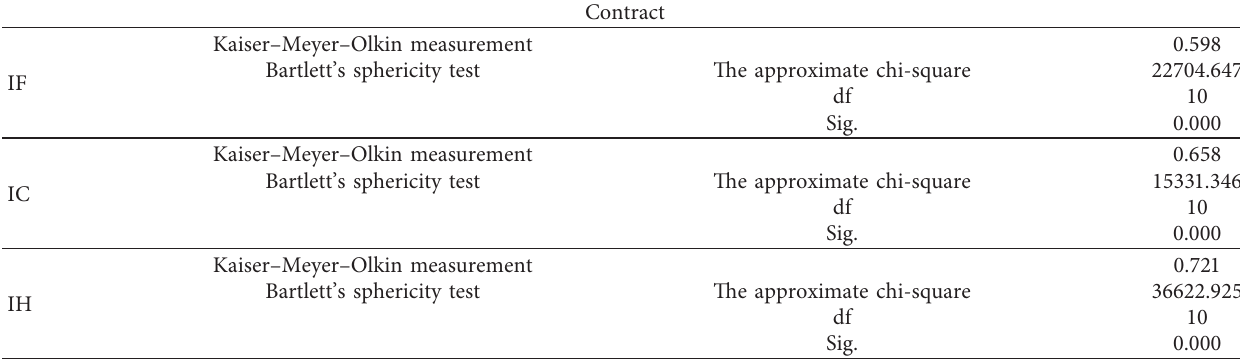
Table 9: KMO and Bartlett tests.